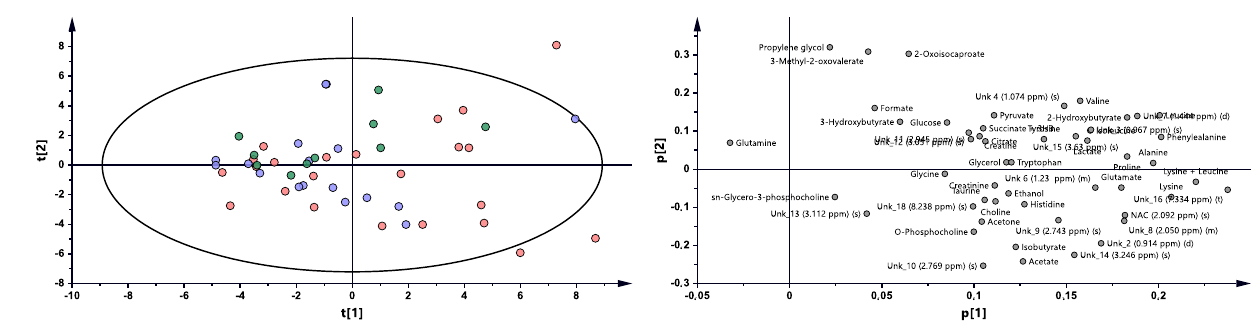
Figure 5. PCA model plot and corresponding loading plot for PsA patients studied at 3 months after initialization of anti-TNF treatment; green—6 months after treatment with TNFi.